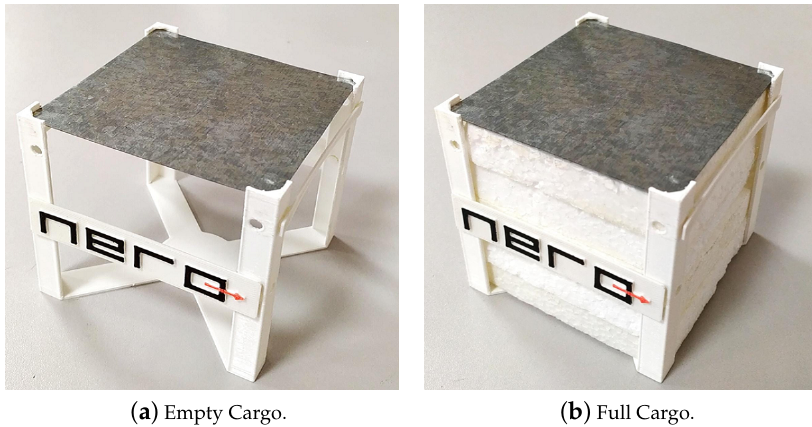
Figure 10. Cargo transported in